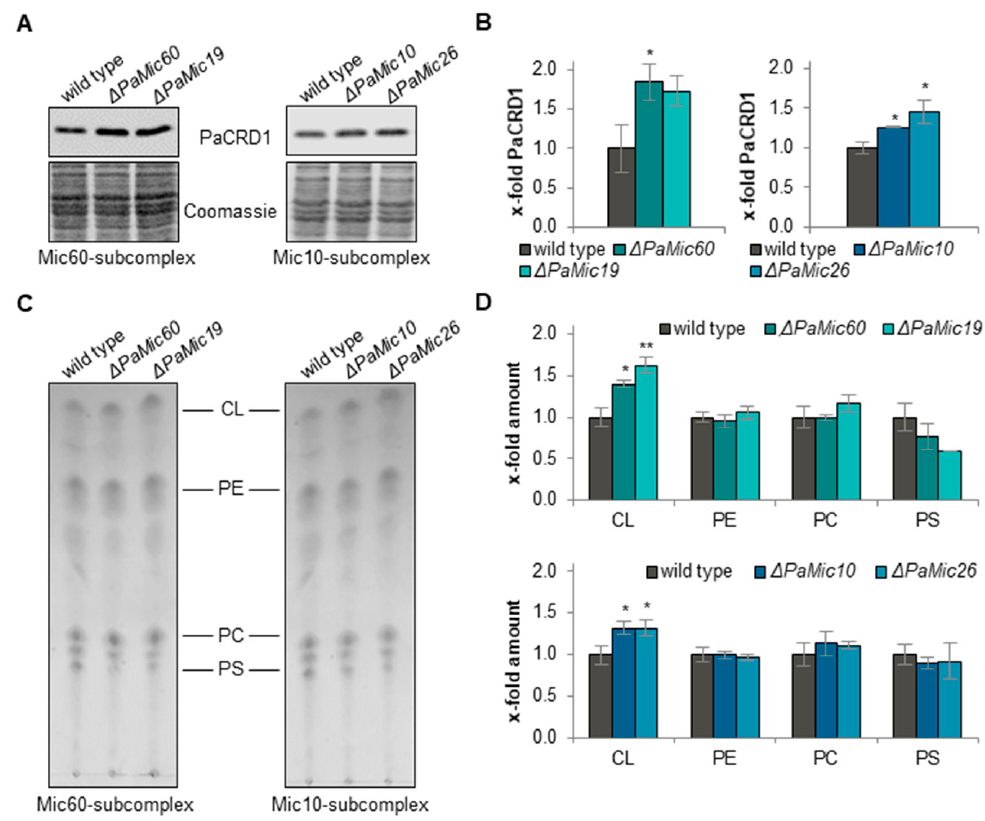
Figure 1. Loss of MICOS impacts cardiolipin synthesis. ( A ) Representative western blot analysis of mitochondrial protein extracts of P. anserina wild type, ∆ PaMic60 , ∆ PaMic19 , ∆ PaMic10 , ∆ PaMic26 using a PaCRD1 antibody. ( B ) Quantification of PaCRD1 amount normalized to the Coomassie-stained gel. PaCRD1 amount in wild type cultures was set to 1. Data represent mean ± SD (3 biological replicates each). ( C ) One-dimensional thin layer chromatography analyses of mitochondrial phospholipids of the wild type, ∆ PaMic60 , ∆ PaMic19 , ∆ PaMic10 and ∆ PaMic26 . CL: cardiolipin; PE: phosphatidylethanolamine; PC: phosphatidylcholine; PS: phosphatidylserine. ( D ) Quantification of phospholipid spots in ( C ). Intensity of each spot was determined and related to the intensity of the whole track. Phospholipid values of the wild type were set to 1. Data represent mean ± SD (3 biological replicates each). * p < 0.05, ** p < 0.01.